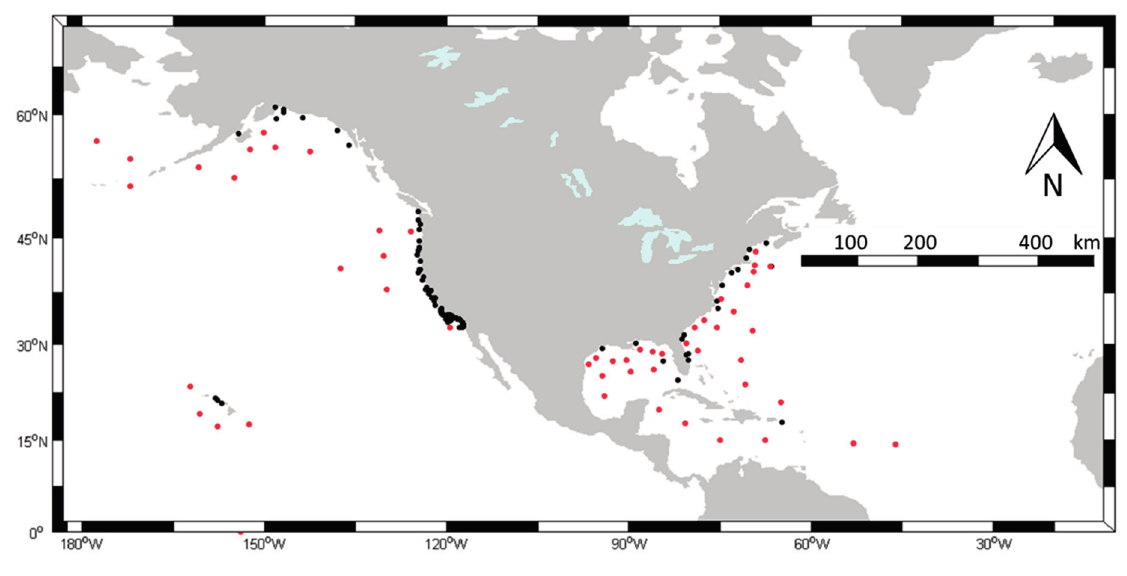
Figure 2. Locations of the 152 collocated buoys used in the validation. 54 of the buoys, deployed in the deep and open ocean are represented by red